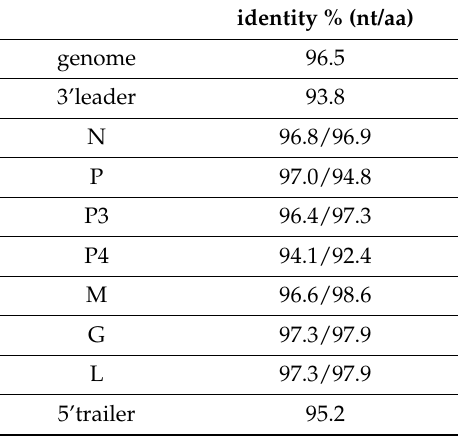
Table 1. Sequence identities between bean-associated cytorhabdovirus and papaya cytorhabdovirus. identity % (nt/aa)